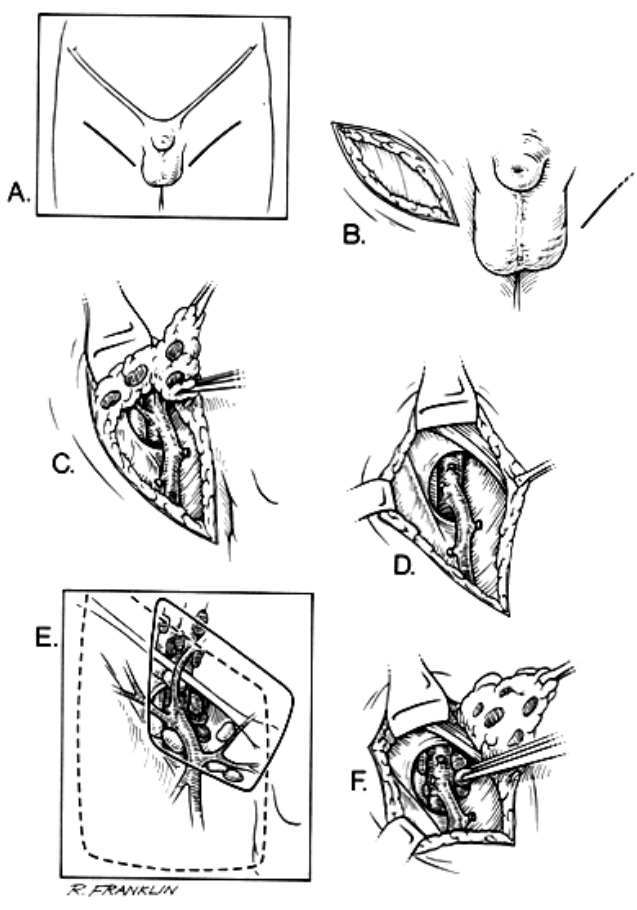
FIGURE 5 . Technique of modified inguinal lymphadenectomy. (A) Placement of inguinal incisions. (B) Incising to Scarpa's fascia. (C) Dissection of the saphenous vein with ligation of its tributaries and cephalad en bloc dissection of nodal package. Saphenous vein is not divided. (D) View following dissection of the superficial nodes. Fascia lata is intact. Dissection extends from 2- cm superior to the incision inferiorly to 4-cm below the lower edge of the incision. (E) Catalona's modified inguinal lymphadenectomy. Lower dissection ends at the lower limit of the fossa ovalis. Dotted border indicates classical lymphadenectomy limits. (F) Detail of Catalona's dissection, when deep inguinal nodes are